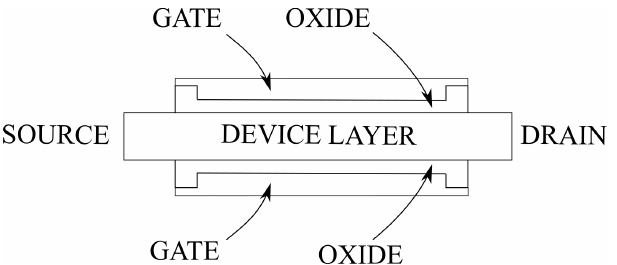
Figure 14. Modified Double Gate junctionless transistor (DG JLT). The gate oxide is thicker near to the gate edges.